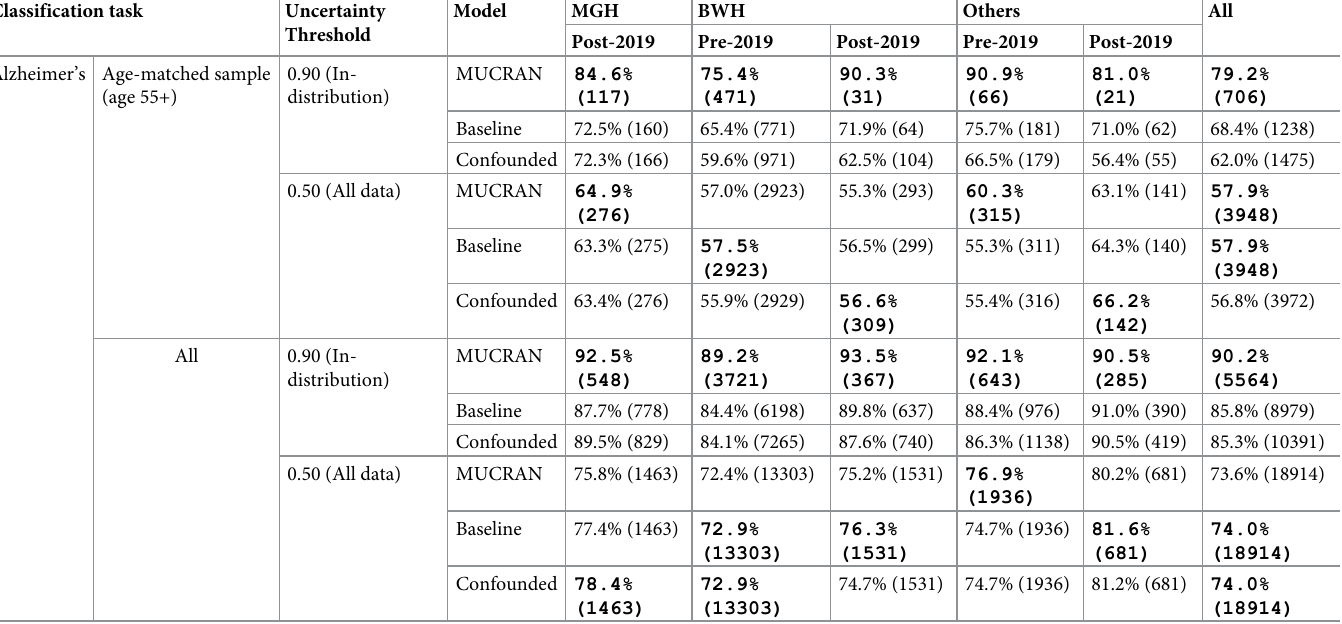
Table 1. Results on Alzheimer’s classification when the whole test set is included (threshold = 0.5), and results, on five test sets and the combined test sets, for which the averaged prediction in its respective category is above 0.90 (i.e., each model in the ensemble unanimously agrees). Shown are the accuracies on the portion of the dataset included after thresholding, and the size of that test set (in parentheses). Included as well are age-matched samples. See also Fig 1C. Classification